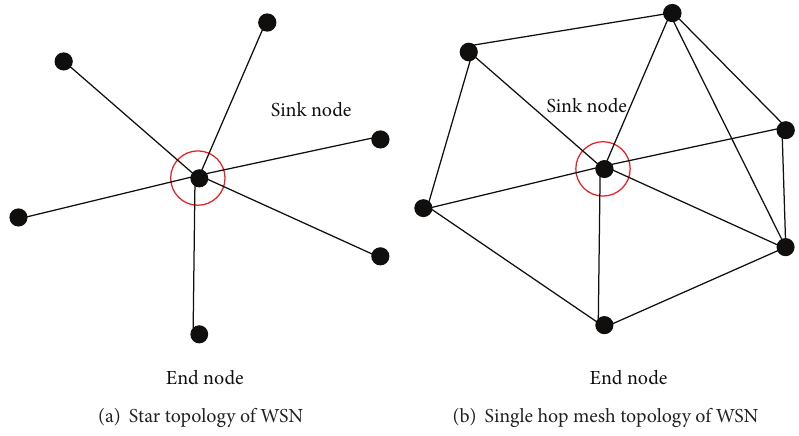
Figure 2: Simplest topology of normal condition monitoring WSN.